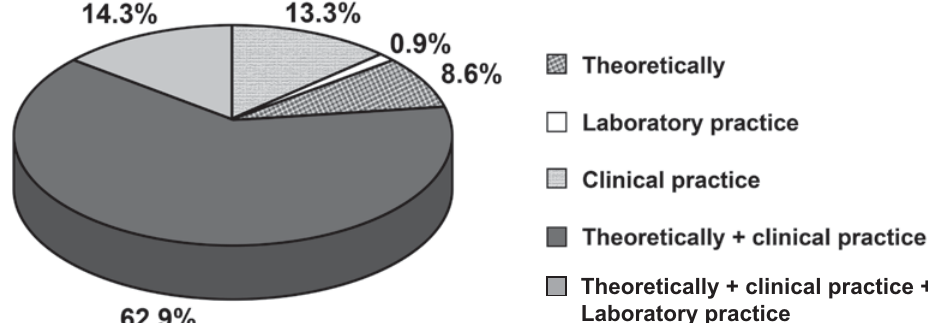
Theoretically + clinical practice FIGURE 2- Answers given by professors from 70 dental schools in Brazil to the question “How is ART being taught?”